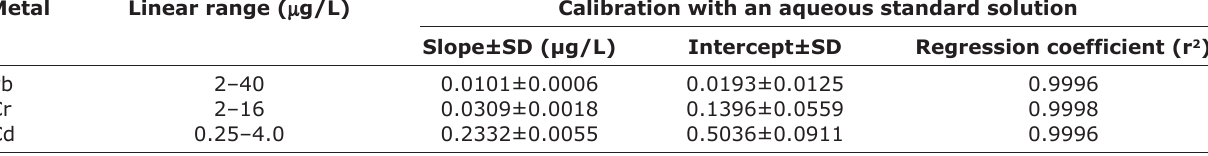
Table-2: Linear regression data of heavy metals in poultry feed. Metal Linear range ( µ g/L)